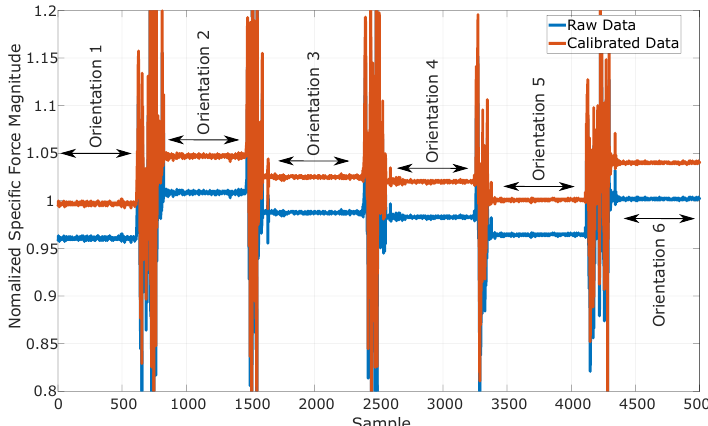
Figure 4. Normalized magnitude of raw and calibrated accelerometer’s data while the sensor is placed in different still